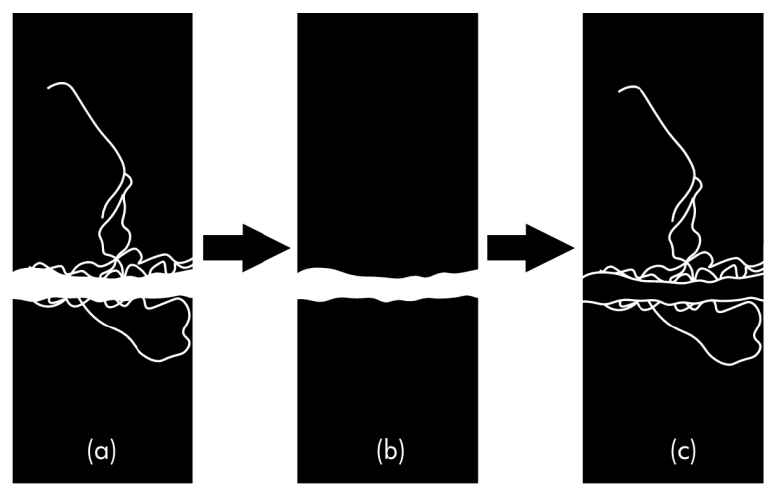
Figure 3. ( a ) New foreground image, ( b ) thread core, ( c ) hairiness (Adapted from [6]).